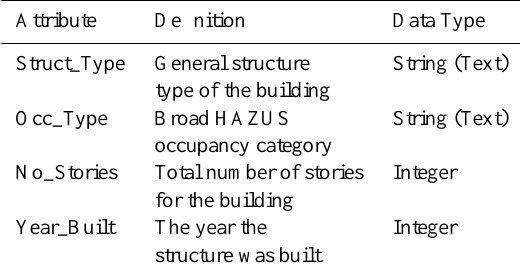
Table 5. Required attributes in building inventory data.